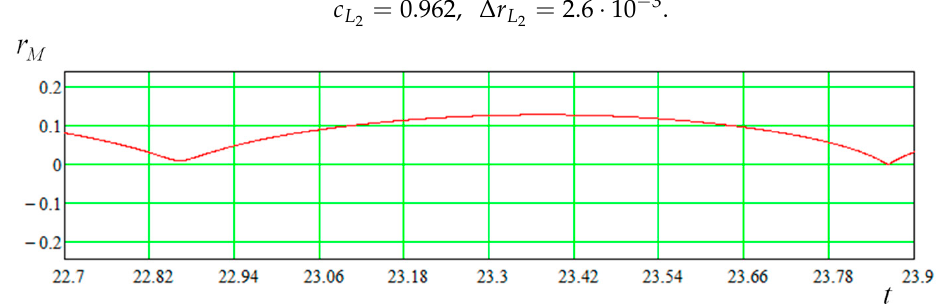
Figure 24. Relative selenocentric r M [undim.] distance between the position of the SC and the final circular orbit of a given radius.